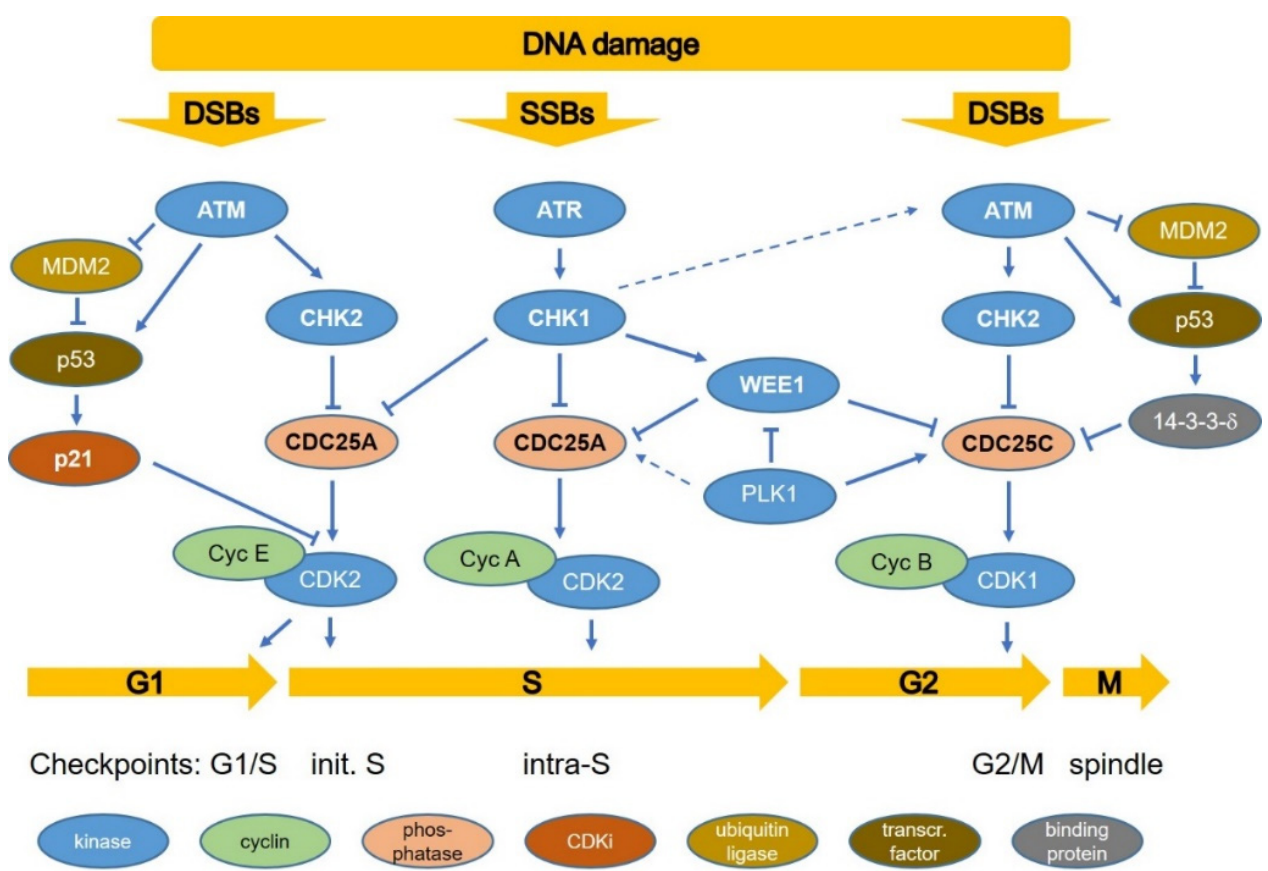
Figure 2. Schematic diagram of cell cycle regulation and DNA damage-induced checkpoints. The ATR kinase is activated by single-stranded DNA and stalled replication forks activating the intra-S checkpoint via CHK1 supported by WEE1. DNA double-strand breaks (DSBs) activate the ATM kinase, which mediates arrest in G1 and G2 via CHK2 supported by WEE1. Cells with wild-type p53 activate the G1/S checkpoint via p21 and contribute to the G2/M arrest. Release from G2/M arrest is mediated by increasing levels of PLK1. Different types of protein are shown in different colors (see Figure 1). The active and inactive forms may be either phosphorylated or unphosphorylated, depending on the specific protein. For further references, see the text.